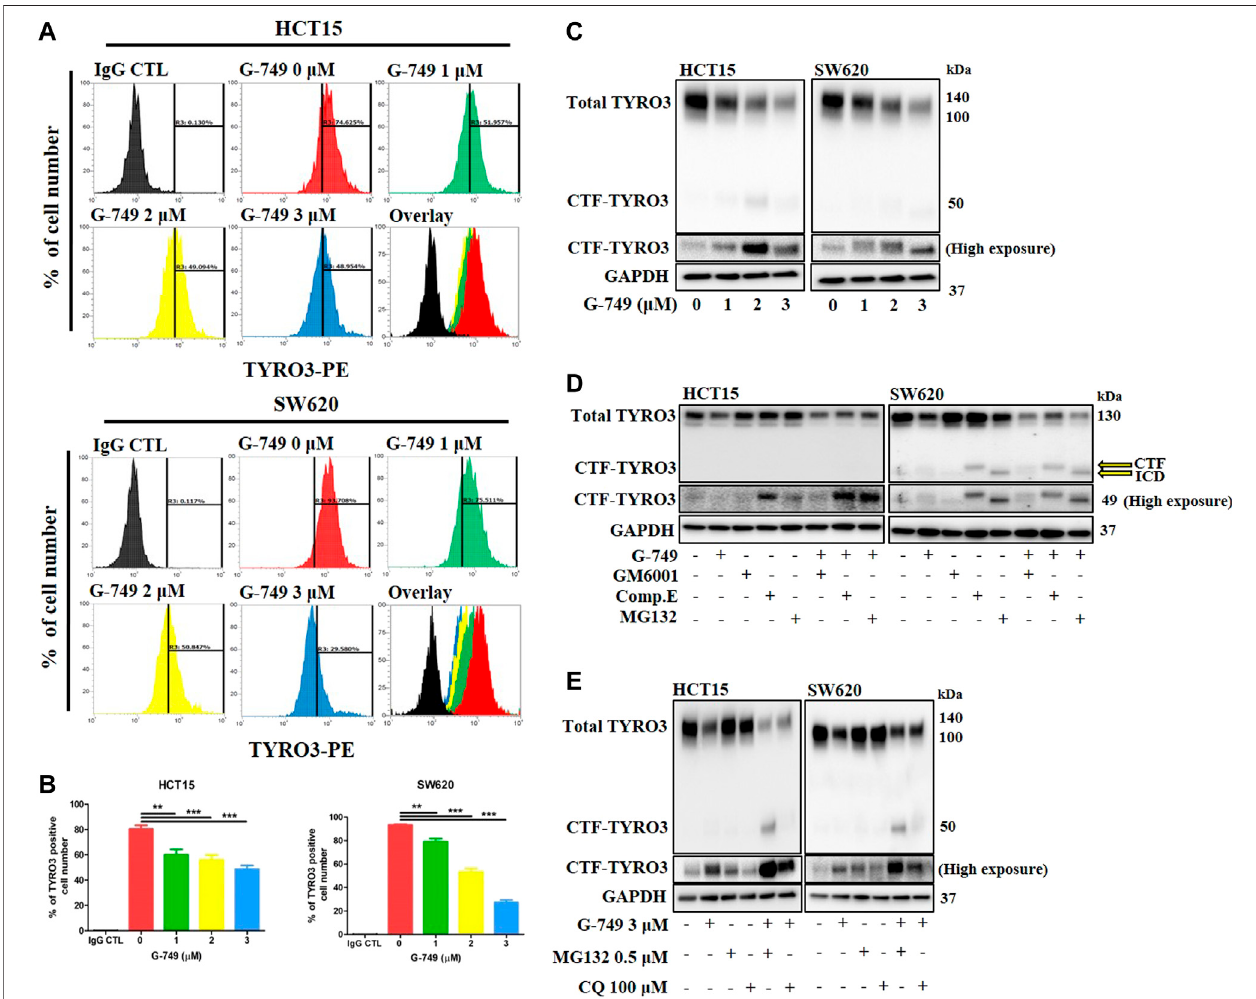
FIGURE3 | G-749 promotes PS-RIP-dependent TYRO3 cleavage and proteasomal degradation incolon cancer cell lines. (A,B) Cells weretreated withG-749 (1, 2 or 3 μ M) or DMSO for 24 h and then stained with PE-conjugated TYRO3 (N-terminal) and PE-conjugated IgG control antibodies. Surface expression of TYRO3 was analyzed by fl ow cytometry. (C) HCT15 and SW620 cells were treated with G-749 for 12 h. Total TYRO3 and C-terminal fragment of TYRO3 levels were detected using an antibody against the C-terminal region of TYRO3. GAPDH was used as a loading control. (D) Cells were pre-treated with GM6001 (30 μ M) for 12 h and then additionallytreatedwithG-749(3 μ M),CompoundE(1 μ M)andMG132(0.5 μ M)for12 h.Theincubatedcellswerelysedandanalyzedbywesternblotwithanti-TYRO3 and – GAPDH antibodies. (E) Cells were co-treated with G-749 (3 μ M) and either MG132 (0.5 μ M) or CQ (100 μ M) for 12 h. Total TYRO3 and C-terminal fragment of TYRO3 levels were detected using an antibody against the C-terminal region of TYRO3. Data are presented as means ± standard deviations (SD). Data were analyzed using one-way ANOVA with Tukey ’ s multiple comparison post-hoc analysis; **** p < 0.0001, *** p < 0.001, ** p < 0.01, * p < 0.05.